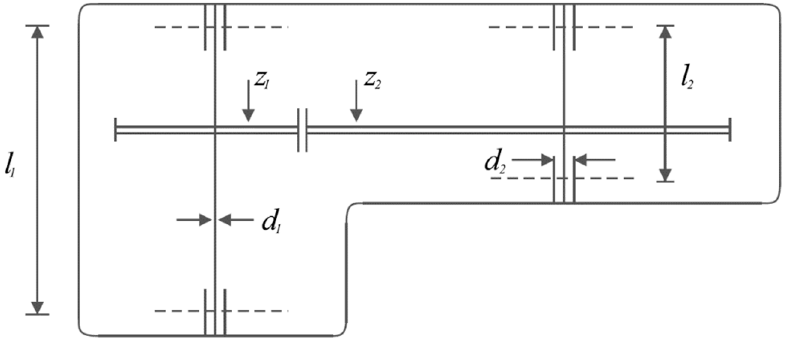
Figure 10. Schematic of speed reducer design.